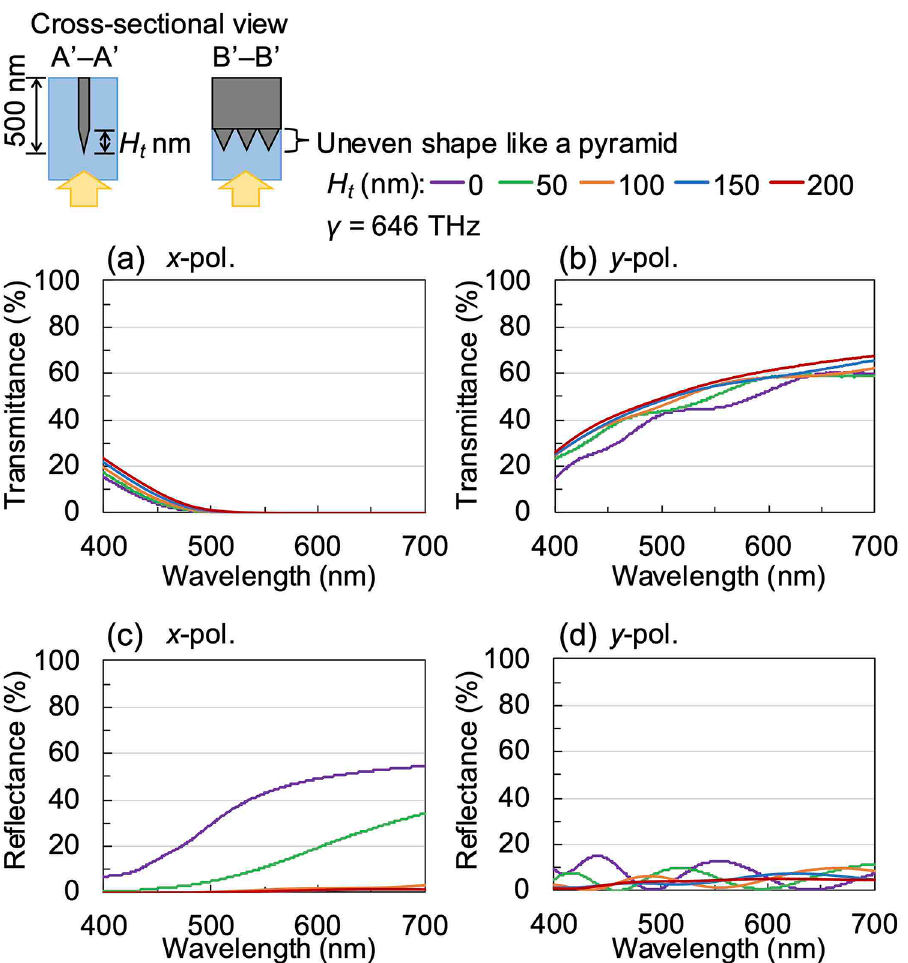
Figure 10. Calculated a , b transmittance and c , d reflectance spectra of embedded WGP sheet with an uneven shape like a pyramid as a function of H t . The polarisation directions are a , c x -polarisation and b , d y